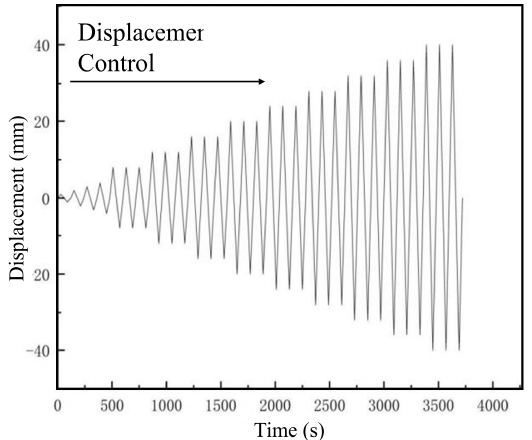
Figure 5. The loading rules.